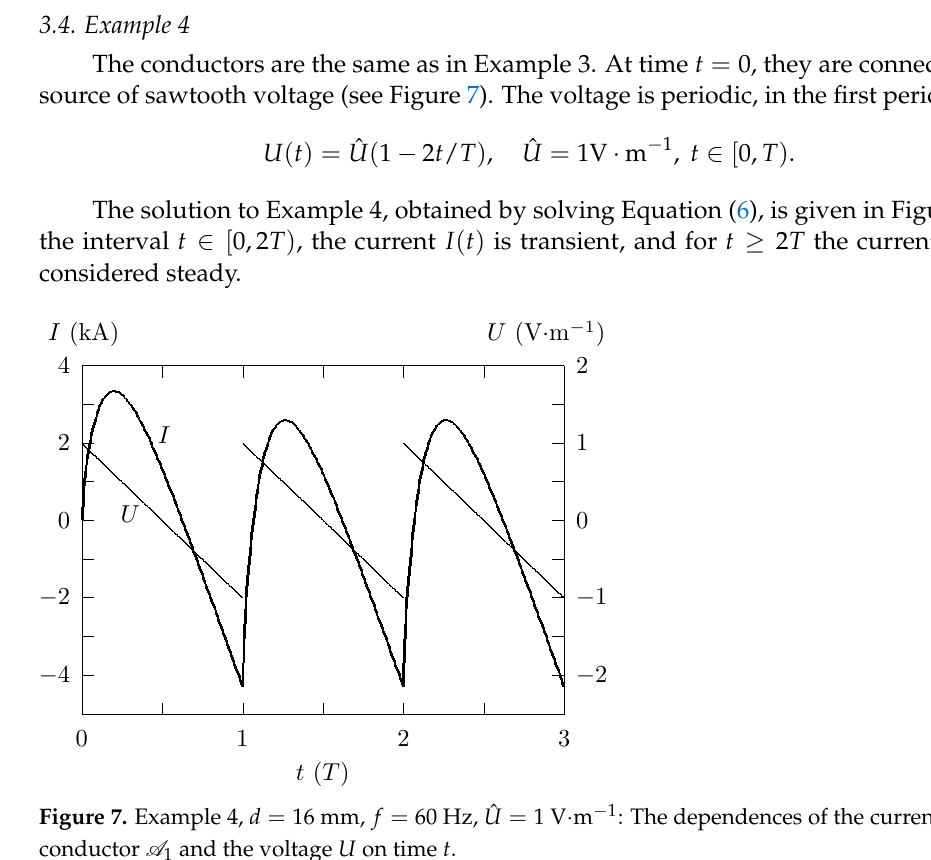
m − 1 : The dependences of the current I in the ·